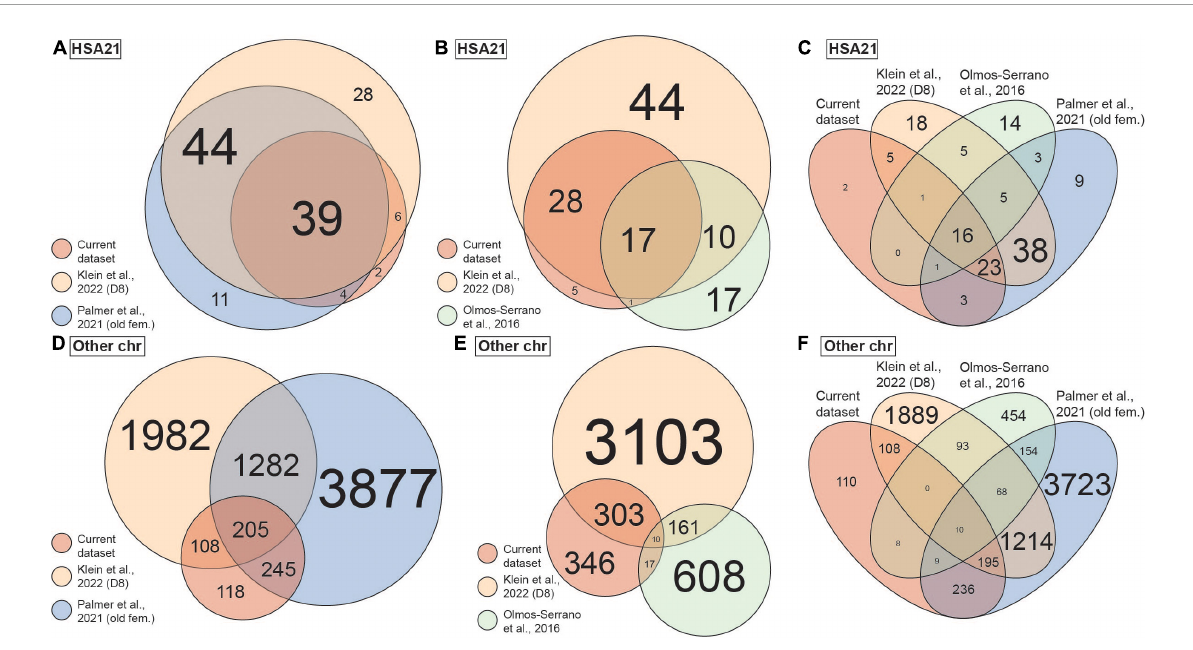
FIGURE5 Overlap of differentially expressed (DEX) genes between the current and published datasets. (A) Venn diagram showing overlap of DEX genes on chromosome 21 (HSA21) between the current, Palmer et al. (2021) and Klein et al. (2022) datasets. Circle size represents number of DEX genes. (B) Venn diagram showing overlap of DEX genes on HSA21 between the current, Olmos-Serrano et al. (2016) and Klein et al. (2022) datasets. Circle size represents number of DEX genes. (C) Venn diagram showing overlap of DEX genes on HSA21 between all four datasets as in panels (A,B) . (D) Venn diagram showing overlap of DEX genes on all chromosomes except HSA21 between the current, Palmer et al. (2021) and Klein et al. (2022) datasets. Circle size represents number of DEX genes. (E) Venn diagram showing overlap of DEX genes on all chromosomes except HAS21 between the current, Olmos-Serrano et al. (2016) and Klein et al. (2022) datasets. Circle size represents number of DEX genes. (F) Venn diagram showing overlap of DEX genes on all chromosomes except HSA21 between all four datasets as in panels (D,E) . Colors represent datasets. Only data of old female (old fem.) samples are included from Palmer et al. (2021) dataset and only data of day 8 WC-24-02-DS (D8) iPSC cultures are included from Klein et al. (2022). Size of the text in all panels represents number of DEX